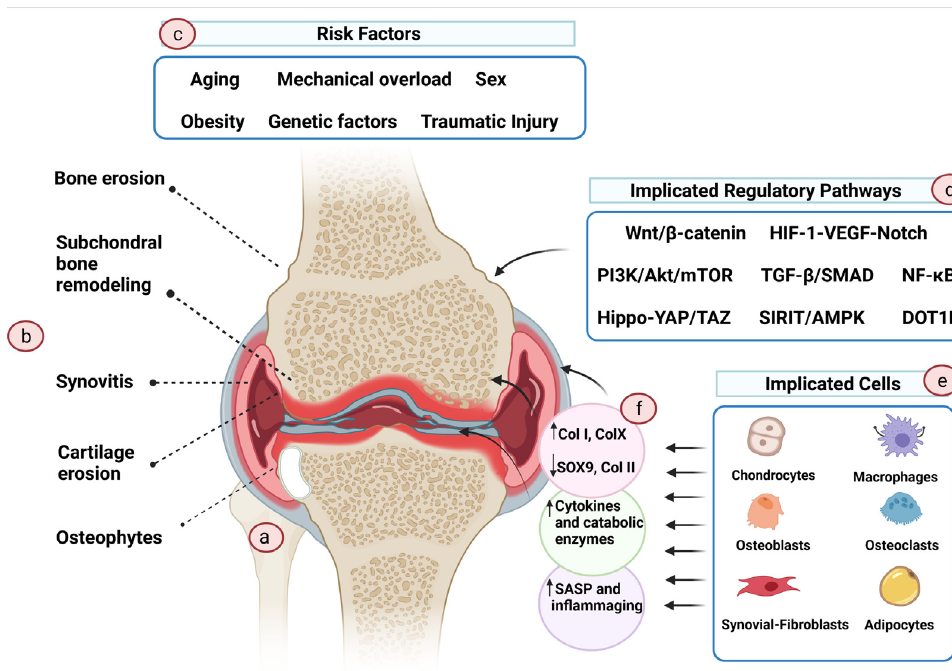
Figure 1. Pathogenesis of osteoarthritis. OA is a complex disease with a wide range of risk factors and causes. ( a ) OA knee. ( b ) OA affects not only the cartilage tissue but also the surrounding tissues, causing modulation of the subchondral plate, inflammation of the synovial tissue, and erosion and osteophyte formation at the supporting bone. ( c ) The primary causative event of OA is largely unknown. Aging, chronic mechanical overload, traumatic injury, genetic variables, sex, and associated hormonal variation are some of the risk factors that have been proposed to increase the vulnerability to OA. ( d ) Multiple regulatory pathways are involved in OA onset and progression, but not all are necessarily implicated in all phenotypes of the disease. ( e ) Cells in the affected tissues actively participate in the disease’s initiation and propagation. ( f ) During OA, these cells change phenotype and, as a result, exhibit altered transcriptome profiles that promote an endless cycle of inflammation and tissue deterioration. (Created with BioRender.com on 11 August 2021).